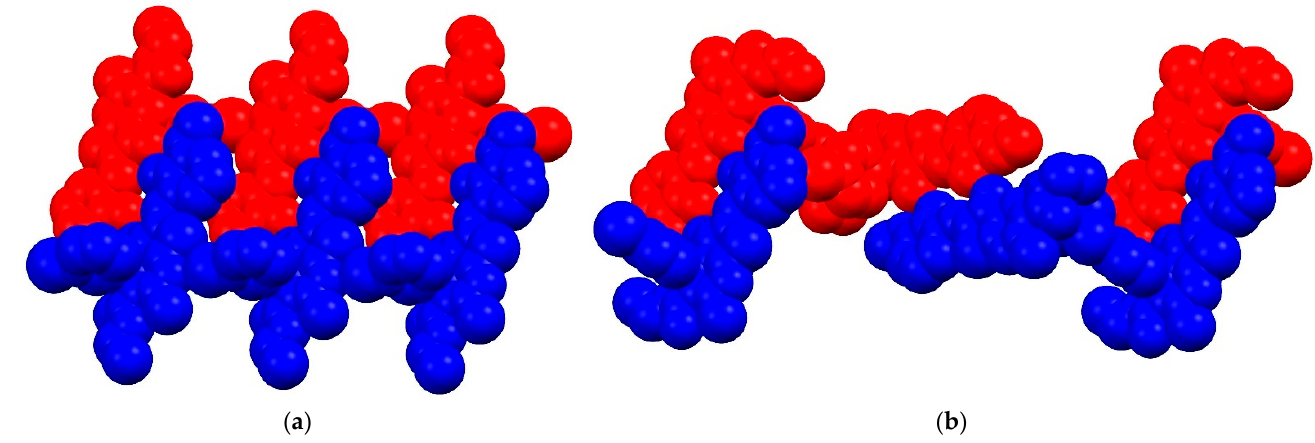
Figure 8. Part of the crystal packaging demonstrating the halogen bonding in the crystals of com- pounds 5 ( a ) and 6 ( b ). R-, S-isomers, hydrogen and halogen bonds are colored in blue, red, light blue and green, respectively.